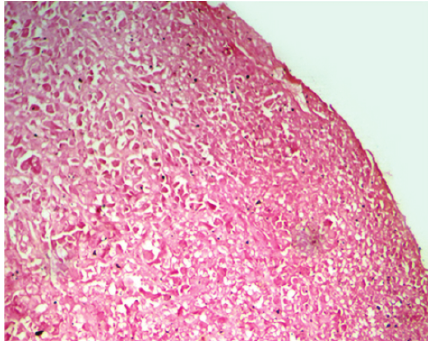
Figure 3: Masson-Fontana staining showing no positive cells